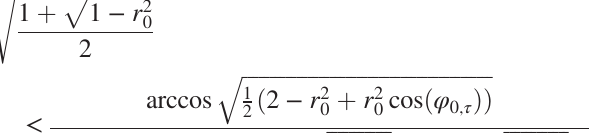
ffiffiffiffiffiffiffiffiffiffiffiffi p 1 − r 2